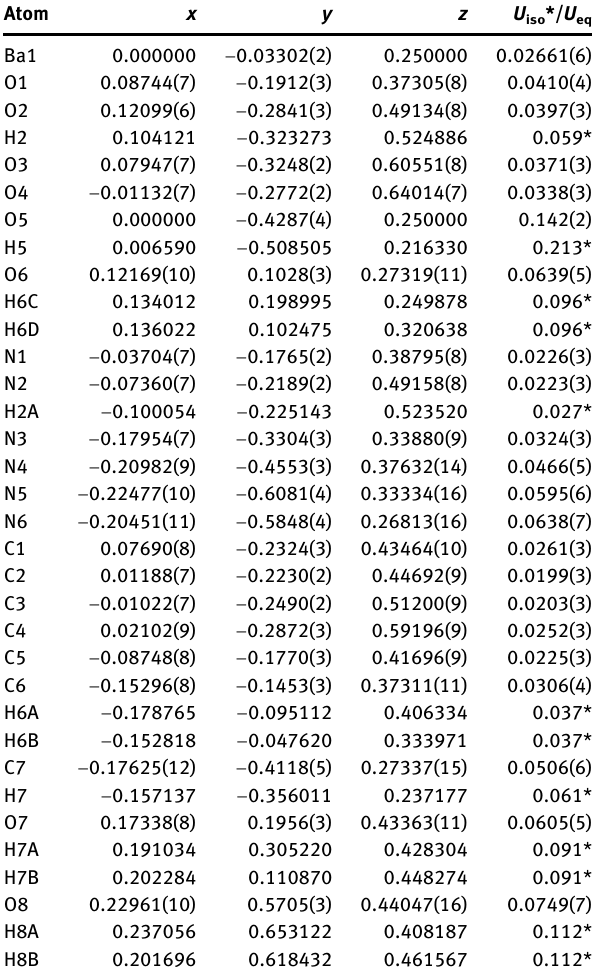
Table  : Fractional atomic coordinates and isotropic or equivalent isotropic displacement parameters (Å  ).